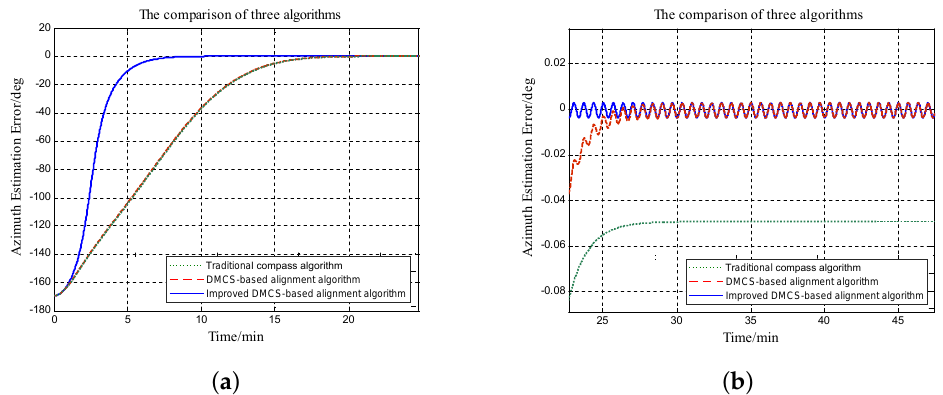
Figure 13. Error curves of the azimuth misalignment angle by utilizing three different initial alignment methods when the initial azimuth misalignment angle is − 170 ◦ . The green dotted line denotes the initial alignment algorithm based on the traditional compass method; the red dashed line denotes the error curve with the initial alignment algorithm based on the DMCS method; the blue solid line denotes the error curve with the improved DMCS-based initial alignment algorithm. ( a ) Errors of